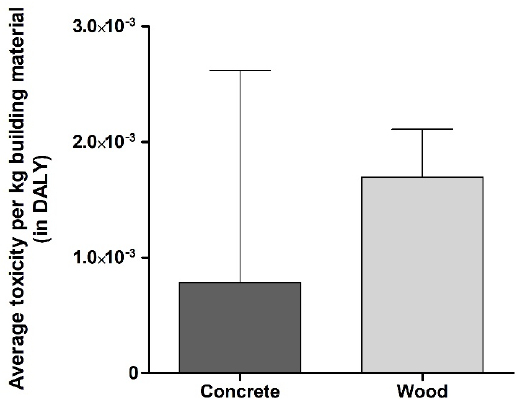
Figure 4. The average embedded toxicity impact per kg building material is given in DALY with a standard deviation. The standard deviation for the average embedded toxicity impact of concrete is of concrete.